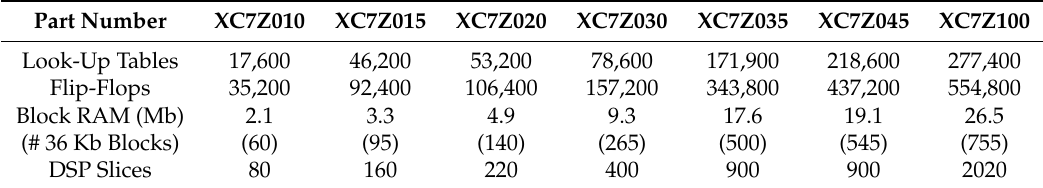
Table 1. Zynq-7000 family overview